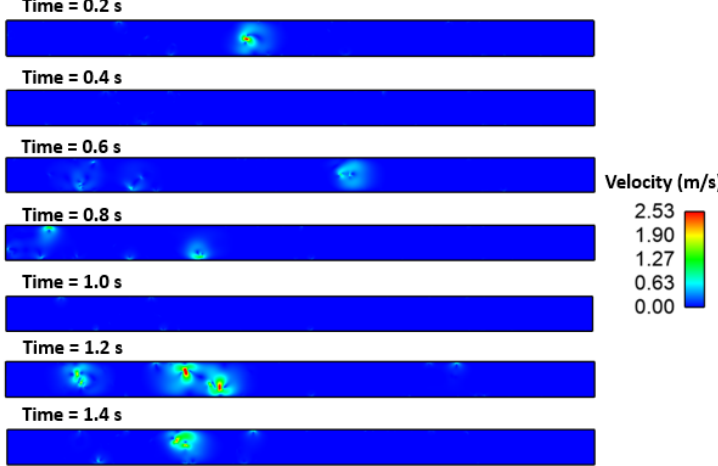
Figure 12. Velocity field of inclusion and molten steel (S: 40 PPM).